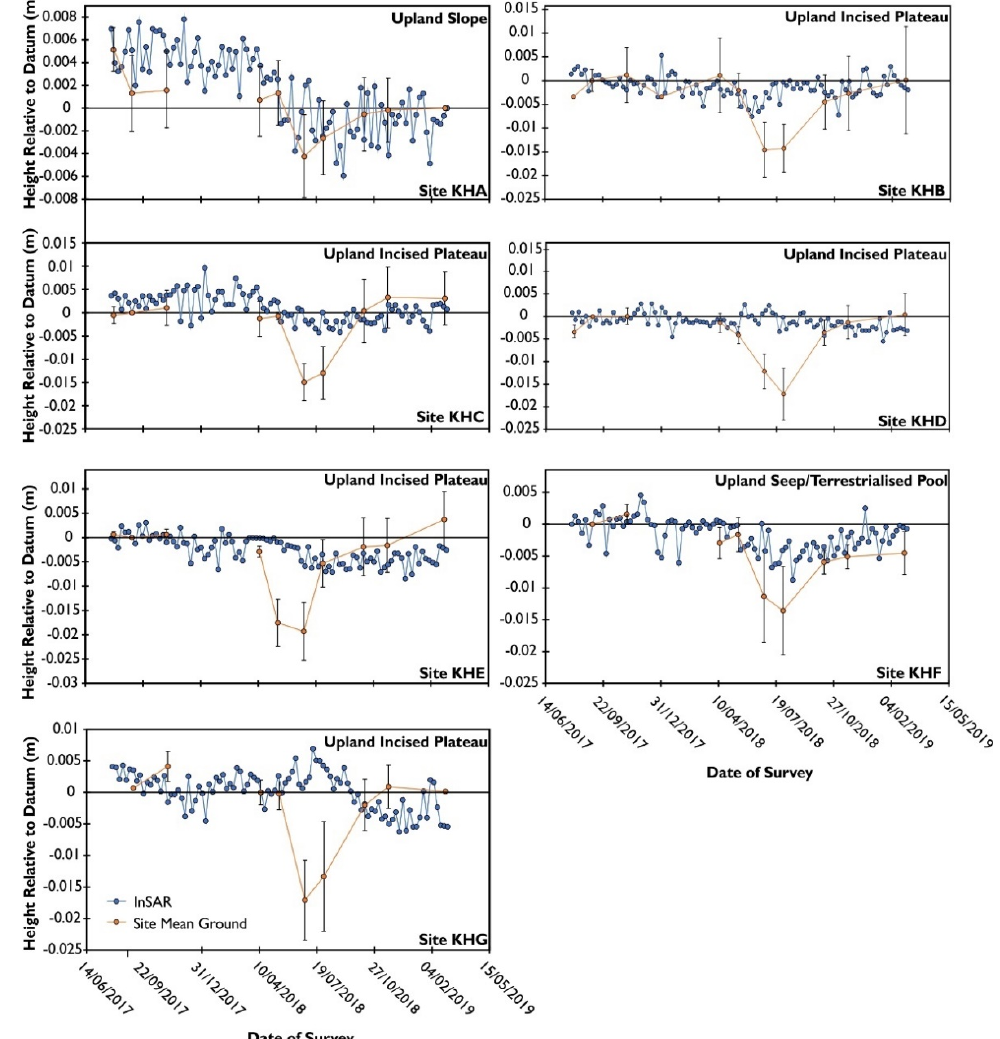
Figure 5. Comparison of APSIS InSAR derived and ground precise leveling (subsite mean) peatland surface motion data at the Upland Knockfin Heights Site. Details of datum dates for each site can be seen in Section 2.